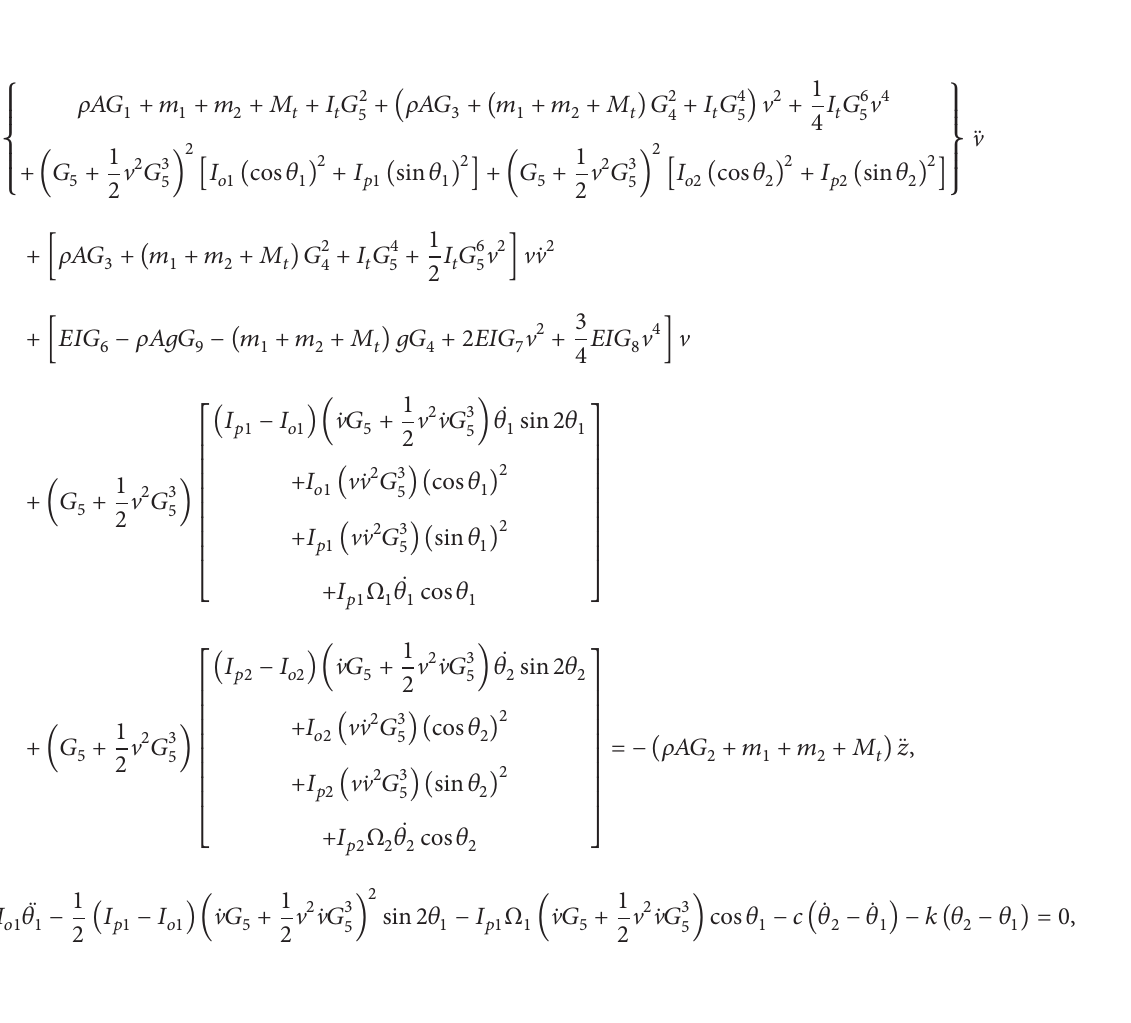
1 2 𝐷 = − ̇𝜃 2𝑐 ( ̇𝜃 ) 2 1